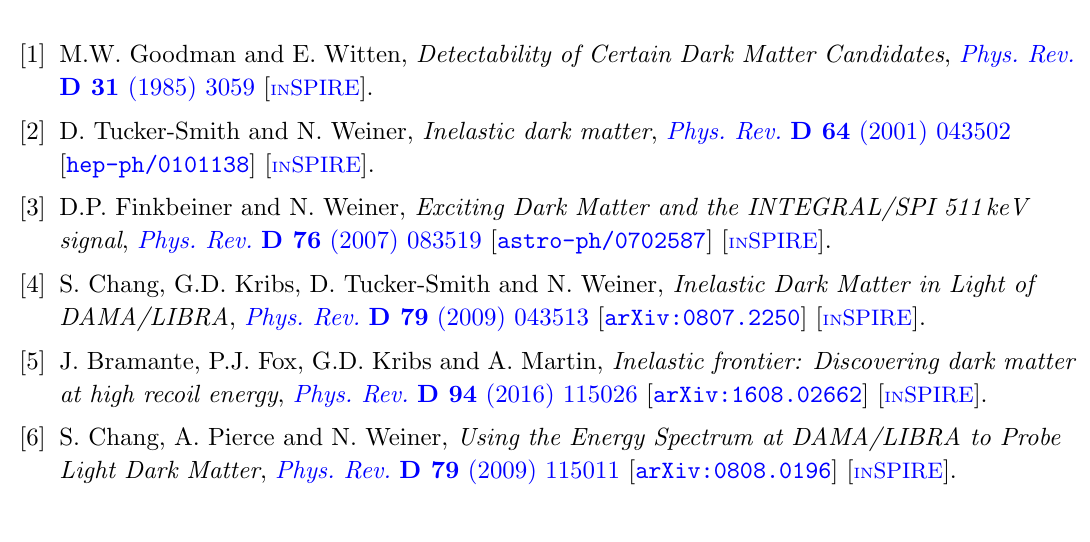
0 : 5GeV ; (cid:11) = 10 (cid:0) 2 . As we can see in the plot, the only lifetimes that depend V